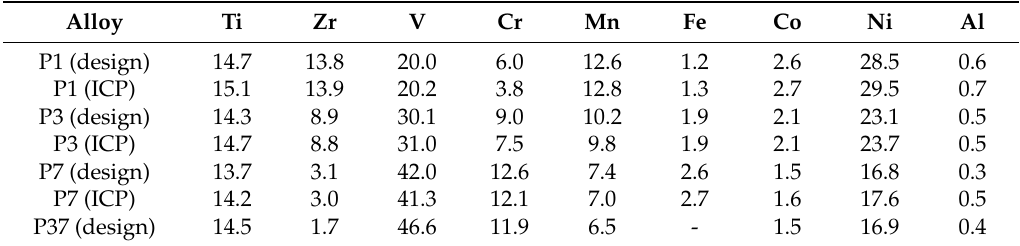
Table 1. Design composition and inductively coupled plasma (ICP) results for Alloys P1, P3 and P7 in